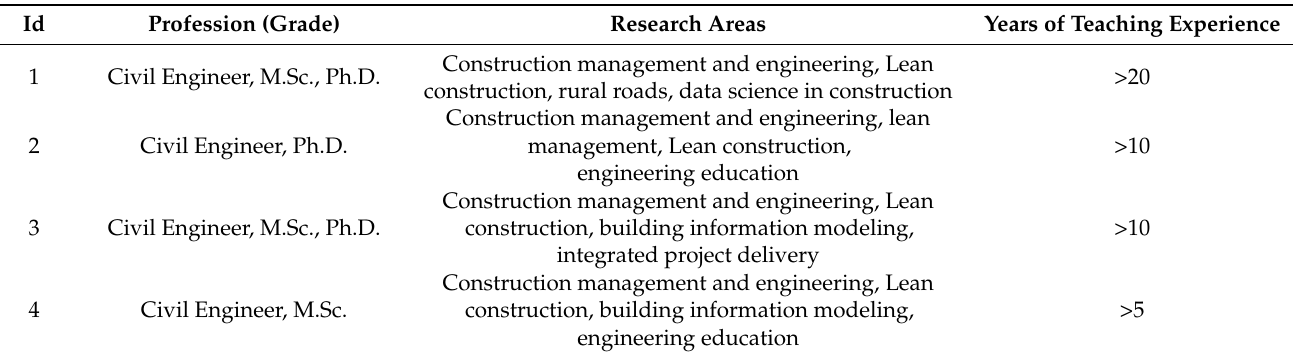
Table 2. Professors who participated in the problem identification